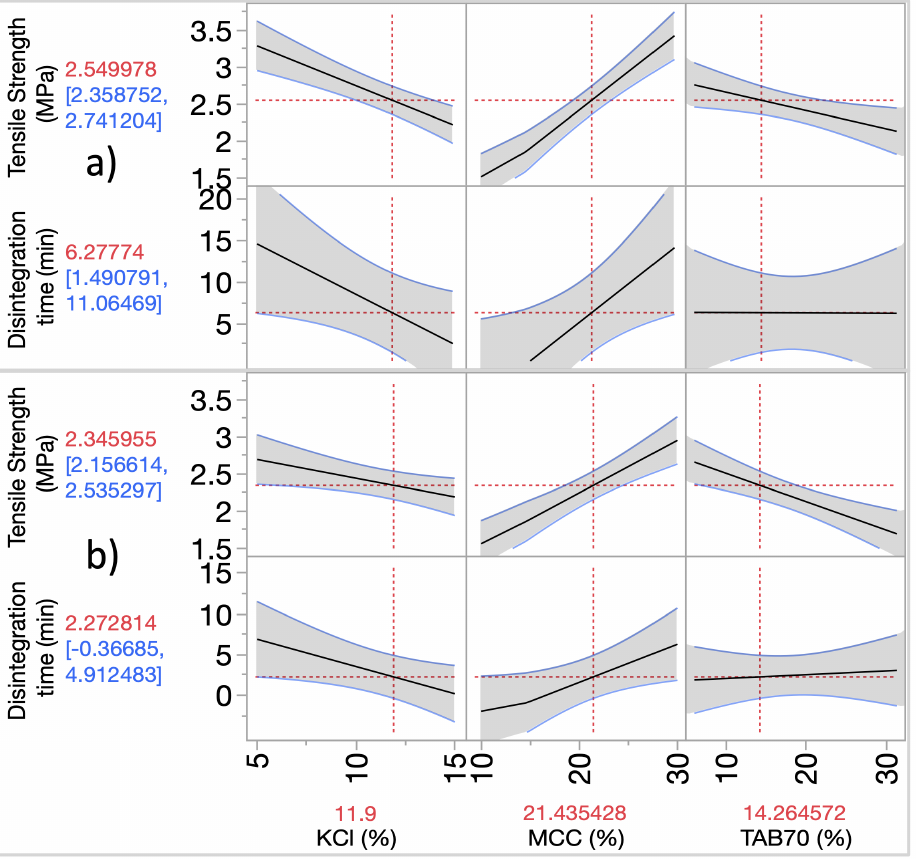
Figure 13. Prediction profiler for the 3 factors (KCl, MCC, TAB70 %) and responses measured (disin- tegration time (min) and tensile strength (MPa) for ( a ) round and ( b ) oblong ITZ-KOL-ASD tablets.